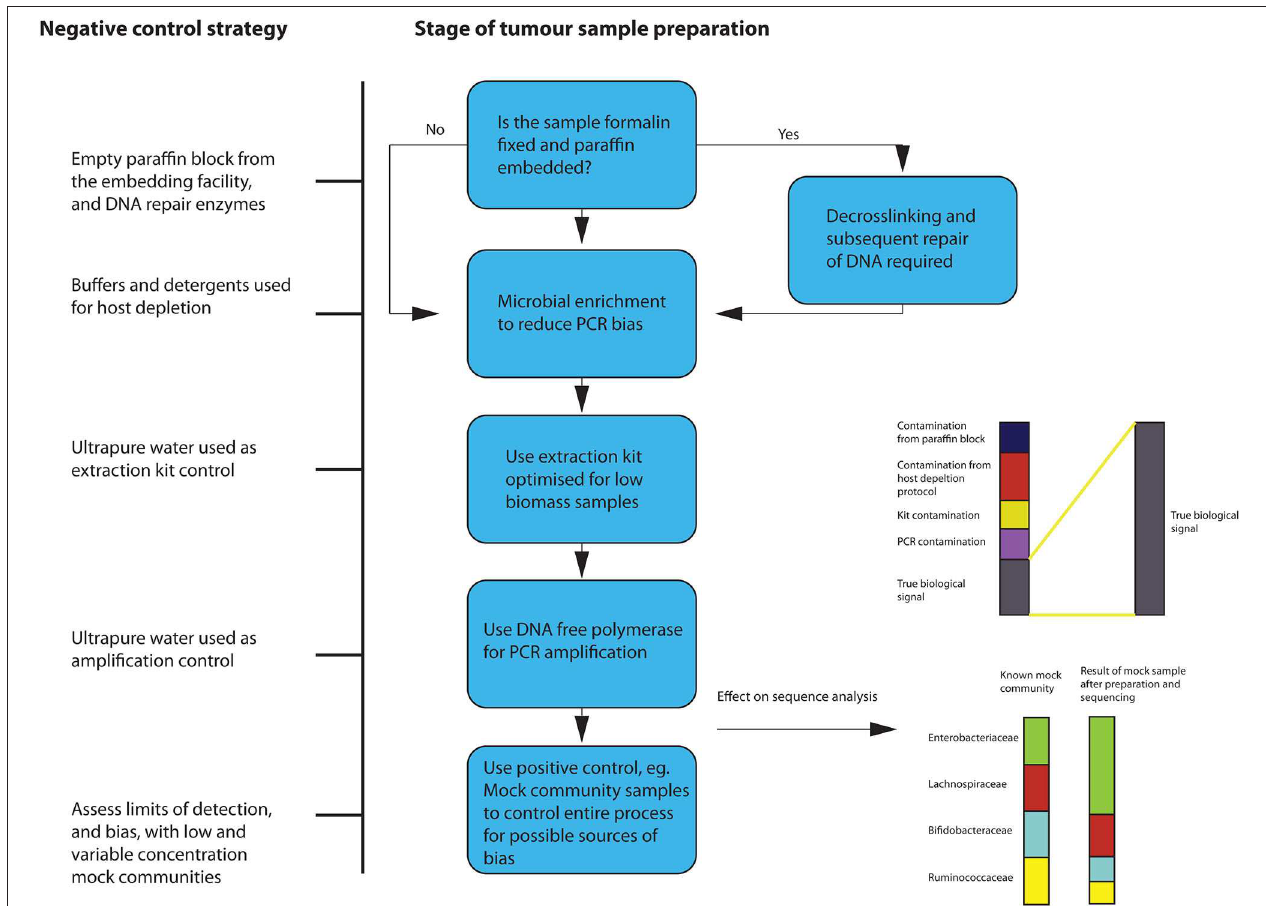
FIGURE 4 | Overview of suggested sample preparation with appropriate control for contamination and